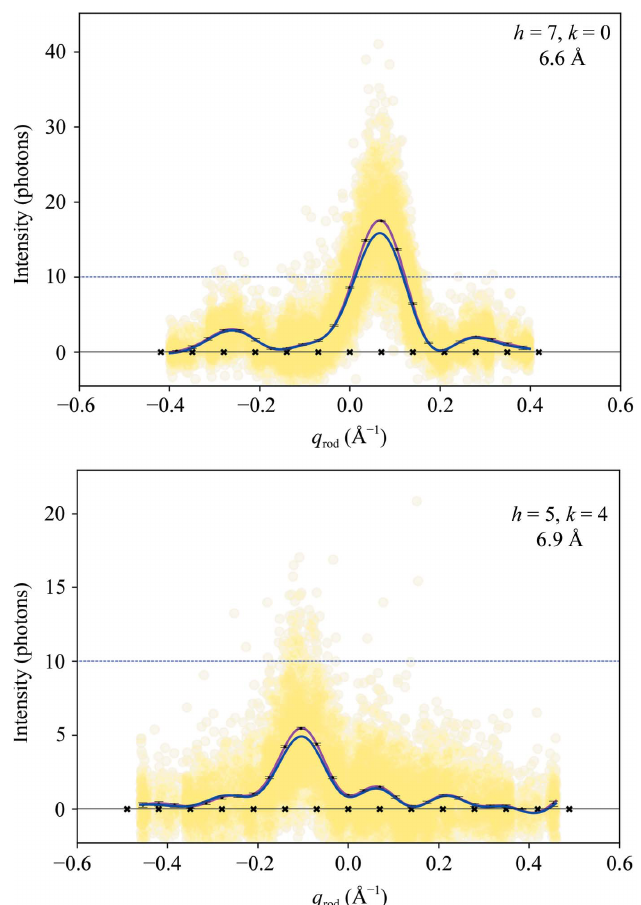
Figure 3 Bragg rod intensities. Intensity observations as a function of q rod for Bragg rods {(7, 0)} and {(5, 4)}. Yellow dots, experimental observations. Blue and magenta lines, preliminary and final intensity model from (3); the black crosses along the horizontal axis mark the base points of the sinc functions of the model. Black dots with error bars, Bayesian estimates of intensities at discrete q rod sampling points. The Miller indices h , k and the in-plane resolution of each Bragg rod are indicated. The dashed blue line represents the intensity level corresponding to ten